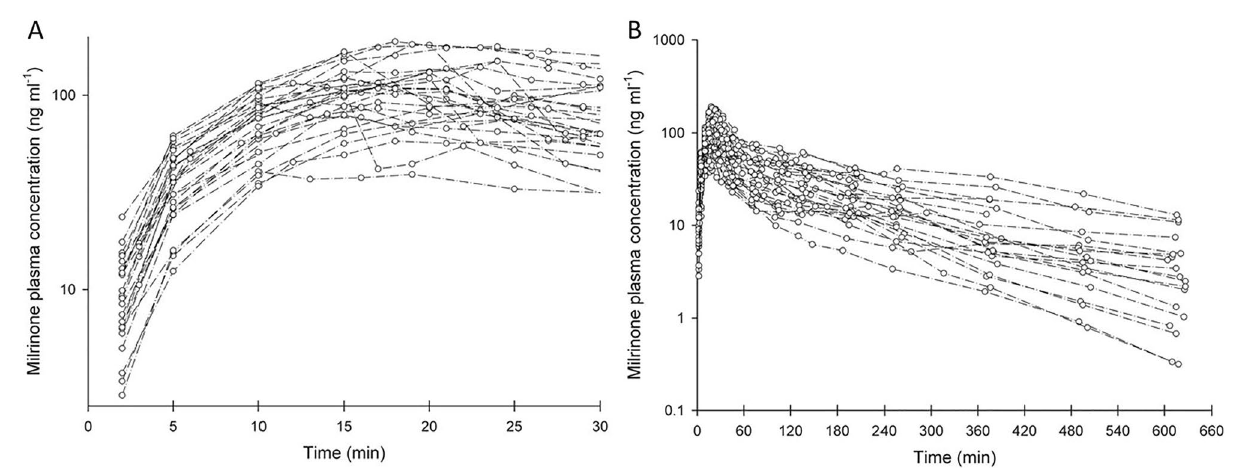
Figure 3. Individual milrinone plasma concentration–time profiles during inhalation (10–30 min) ( A ) and overall until 600 min after termination of inhalation ( B ) (n = 28).